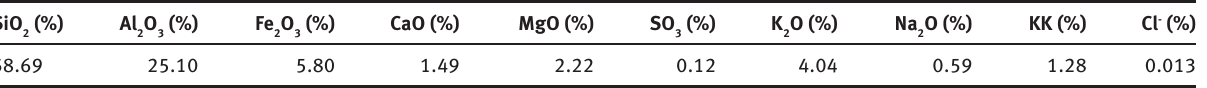
Table 2: Chemical composition of fly ash [57].